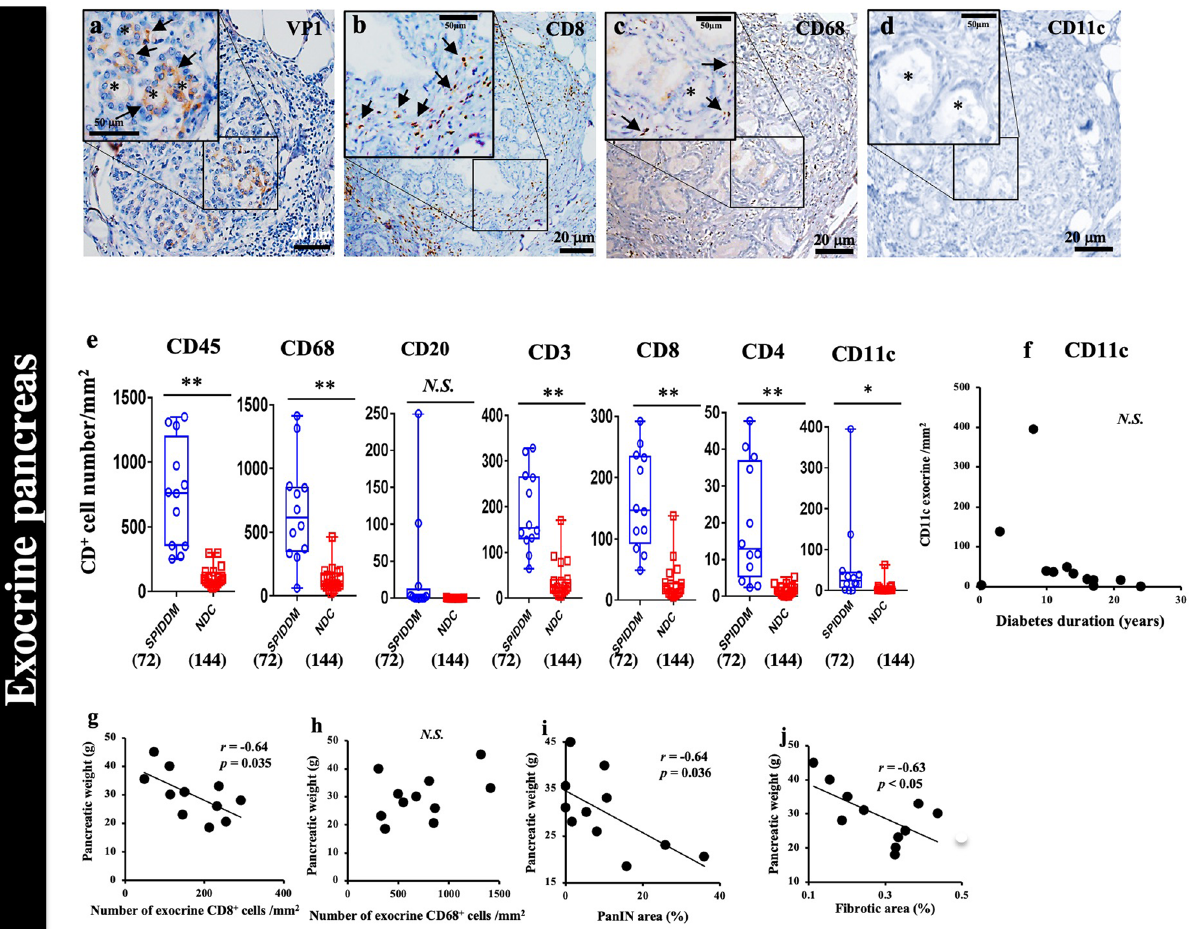
Figure 7. EV and pancreatic exocrine tissue inflammation and association with pancreatic weight in SPIDDM. (a–d) Serial sections of exocrine pancreas in a PanIN lobe stained for VP1 ( a ), CD8 ( b ), CD68 ( c ), and CD11c ( d ) in SPIDDM (Case SP2). VP1- and ADM-positive cell clusters ( a , brown) are infiltrated by CD8 + T cells ( b ) and CD68 + macrophages ( c ). No CD11c + cells are observed ( d ). Asterisks: ADM-changed acinar cells. ( e ) Numbers of CD45 + , CD68 + , CD8 + , CD4 + , and CD11c + cells, but not CD20 + cells, in the exocrine pancreas are significantly higher in SPIDDM patients than in non-DCs (NDC). Numbers in parentheses indicate number of areas counted. * P < 0.05 and ** P < 0.01, Tukey’s test. ( f ) The number of CD11c + dendritic cells in the exocrine pancreas tends to decrease in some cases with duration of SPIDDM exceeding 10 years. ( g ) The number of CD8 + T cells in the exocrine pancreas of SPIDDM is negatively associated with SPIDDM pancreas weight. P = 0.035 by Pearson’s correlation coefficient. ( h ) The number of CD68 + macrophages in the exocrine pancreas of SPIDDM does not correlate with SPIDDM pancreas weight. ( i ) The PanIN area in SPIDDM pancreas correlates negatively with pancreatic weight. P = 0.036 by Pearson’s correlation coefficient. ( j ) The fibrosis area of SPIDDM correlates negatively with SPIDDM pancreas weight. P < 0.05 by Pearson’s correlation